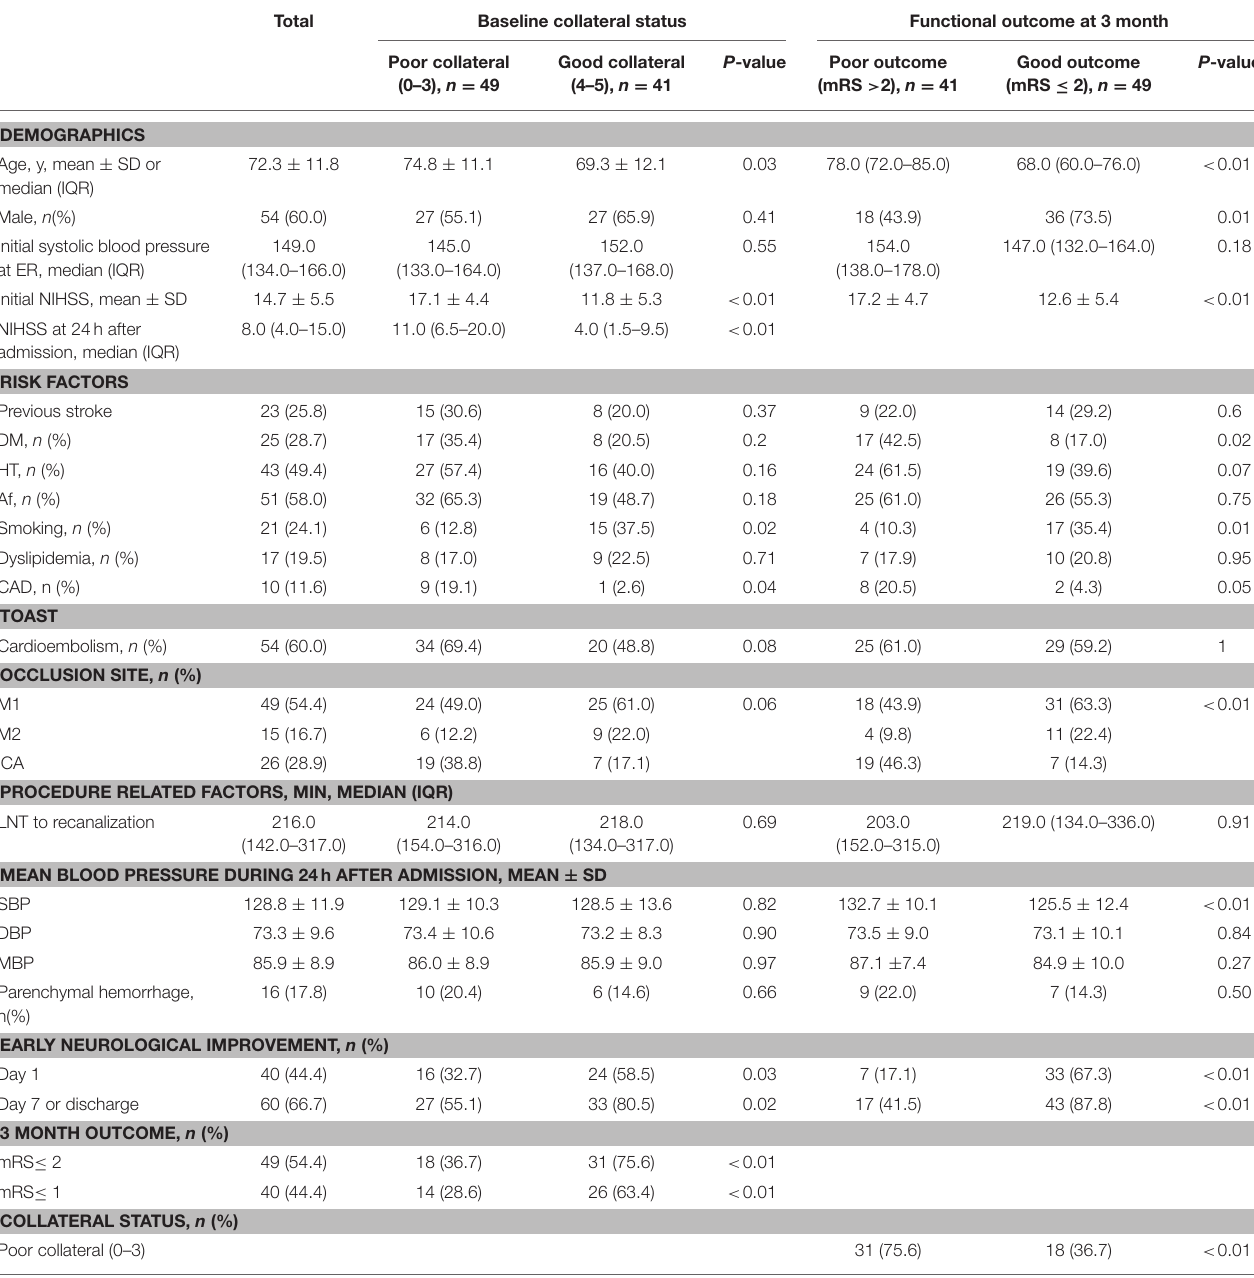
TABLE 1 | Baseline characteristics of the study subjects based on the collateral status and functional